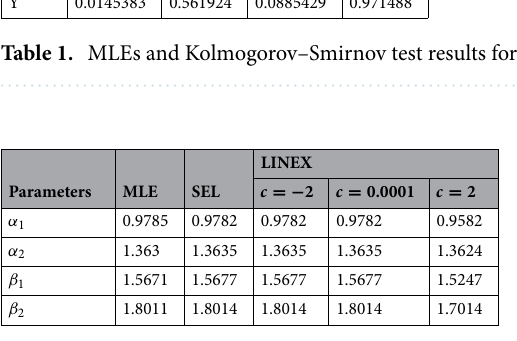
Table 2. Different point estimates for the parameters α 1 , α 2 , β 1 and β 2 .